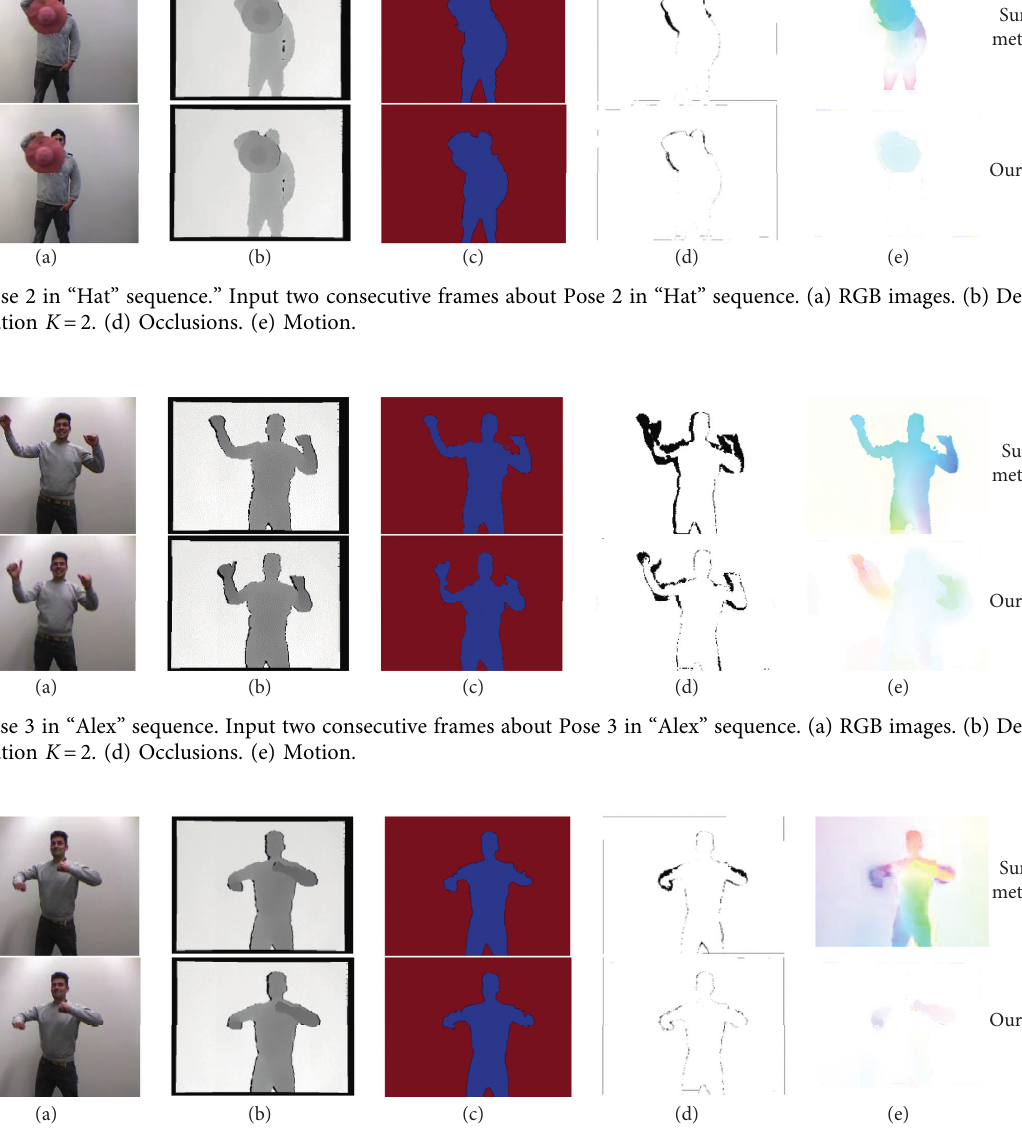
Figure 9: Pose 4 in “Alex” sequence. Input two consecutive frames about Pose 4 in “Alex” sequence. (a) RGB images. (b) Depth images. (c) Segmentation K � 2. (d) Occlusions. (e)